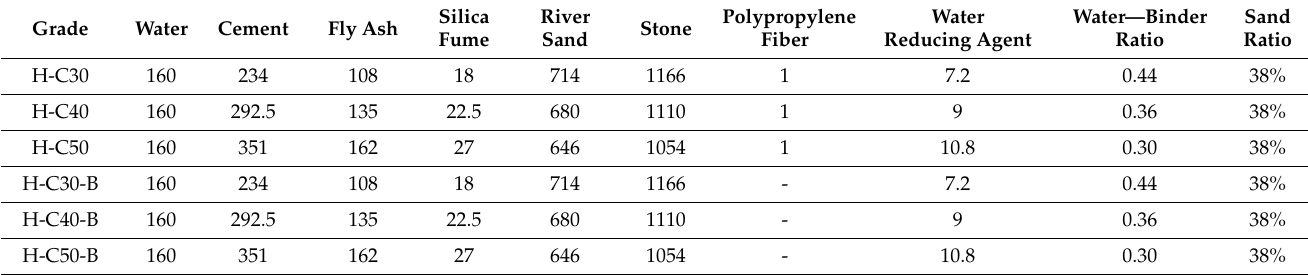
Table 6. High-performance concrete mix ratio (kg/m 3